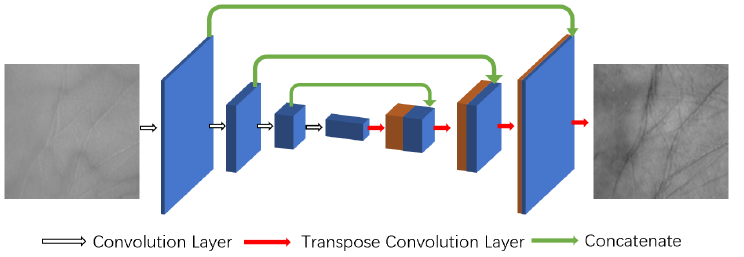
Figure 3. PT-net